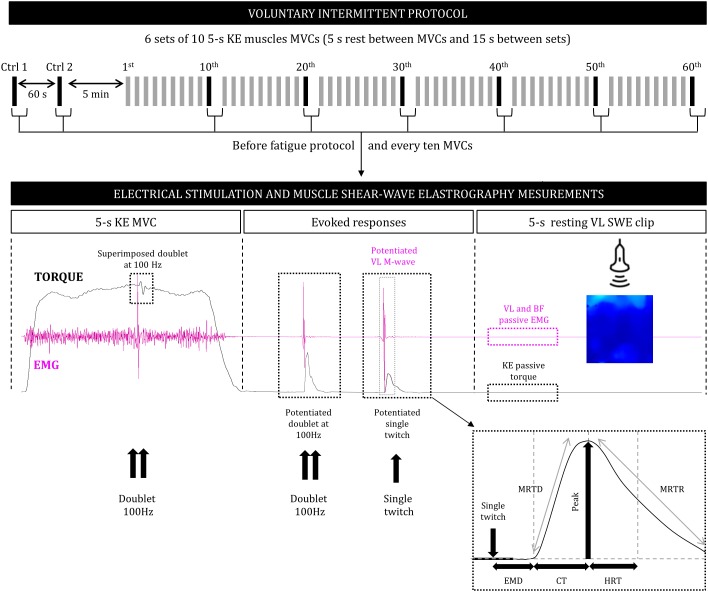
Design of the voluntary intermittent fatigue protocol (top), consisting of a series of voluntary force and electrical stimulation and muscle shear-wave elastography measurements performed before the series and during and after every 10 MVC (bottom). KE, knee extensors; MVC, maximal voluntary contraction; SWE, shear-wave elastography; EMG, surface electromyography; VL, vastus lateralis; BF, biceps femoris; P, peak torque; EMD, electromechanical delay; CT, contraction time; HRT, half relaxation time; MRTD, maximal rate of torque development; MRTR, maximal rate of torque relaxation.